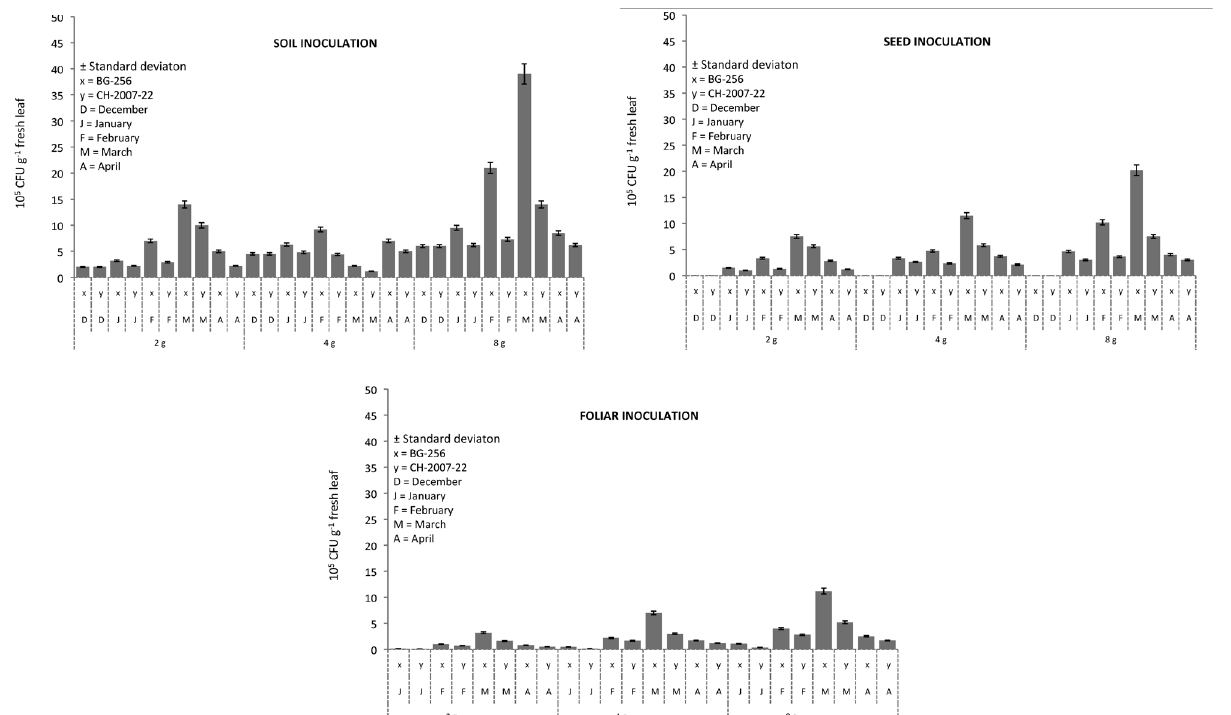
Figure 2. Correlation between disease severity and yield decline of chickpea cultivars subjected to foliar and seed inoculation with Botrytis